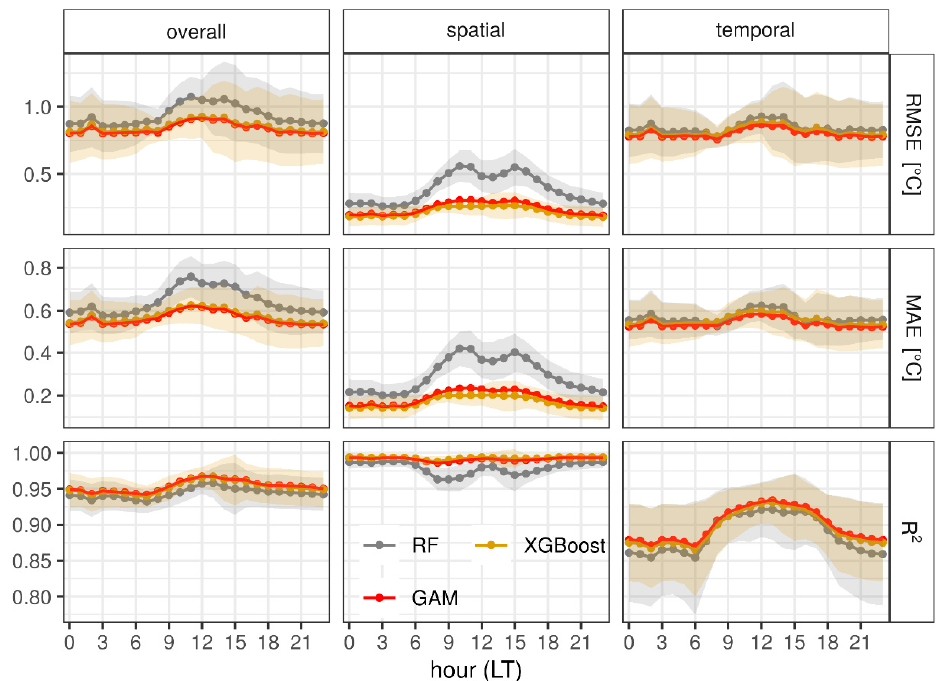
Figure 6. The mean Stage 1 model performance (RMSE, MAE, R 2 ) of individual methods based on the 5-fold cross-validation performed for each year: overall and disaggregated by spatial and temporal components. The error band indicates the standard deviation among the years 2004–2017 (for the generalized additive model (GAM), only means are drawn).